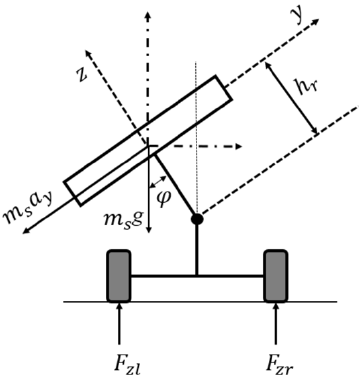
Figure 2. Vehicle roll dynamics model.